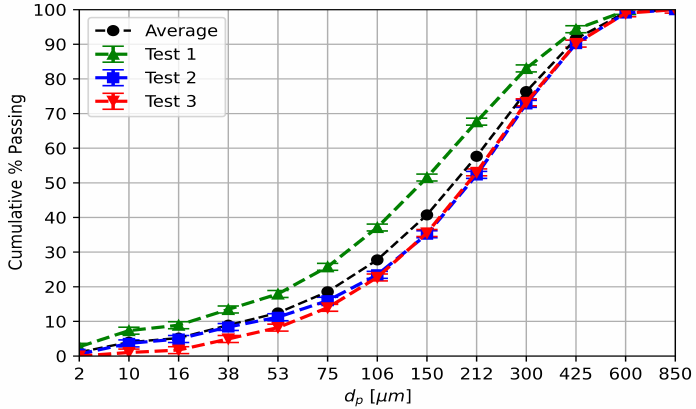
Figure 2. Feed particle size distribution—cumulative passing.